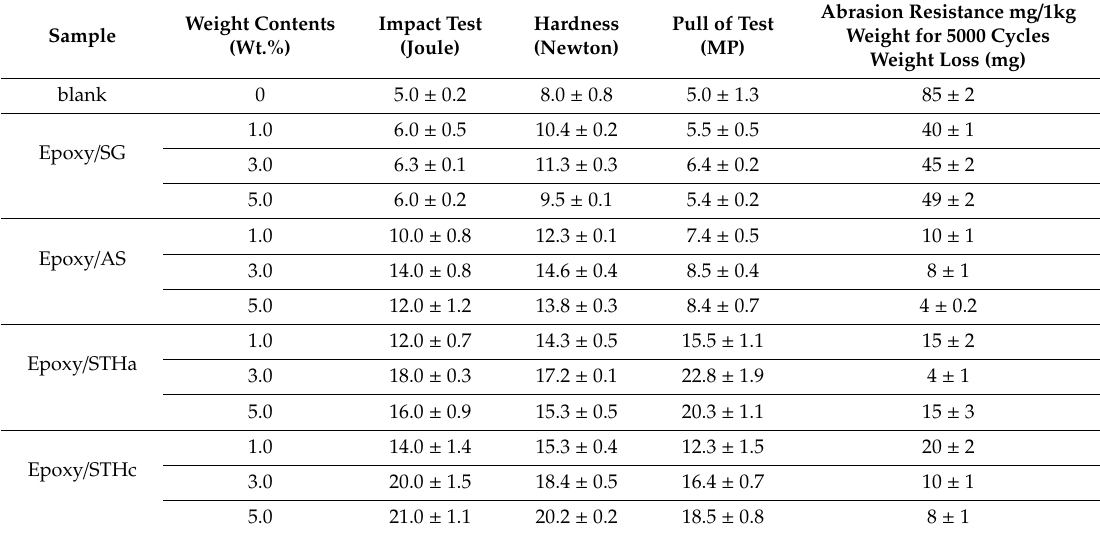
Table 1. Mechanical tests of the cured epoxy resins modified with di ff erent weight percentages of SG, AS, STHa and